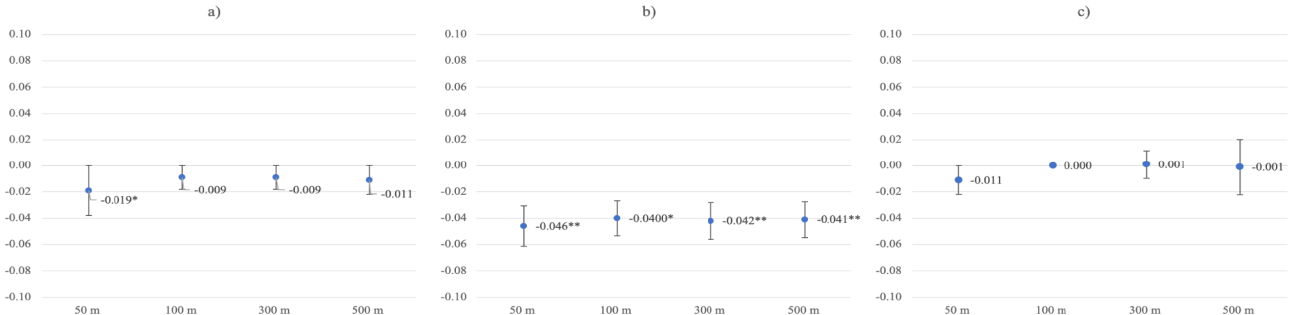
Figure 4. Greenspace ß coefficients with standard errors for unadjusted burnout symptoms models in the ( a ) whole sample, ( b ) non-working group, and ( c ) working group. * Statistical significance at p ≤ 0.05. ** Statistical significance at p ≤ 0.01.